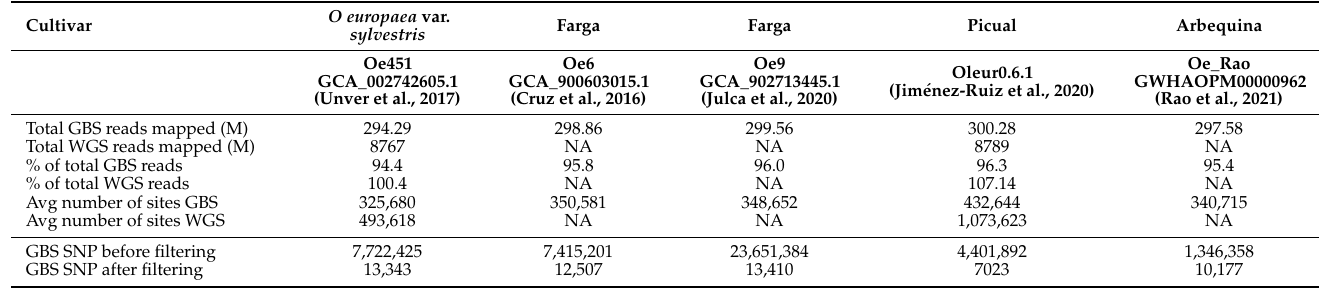
Table 3. GBS and WGS read mapping and variant